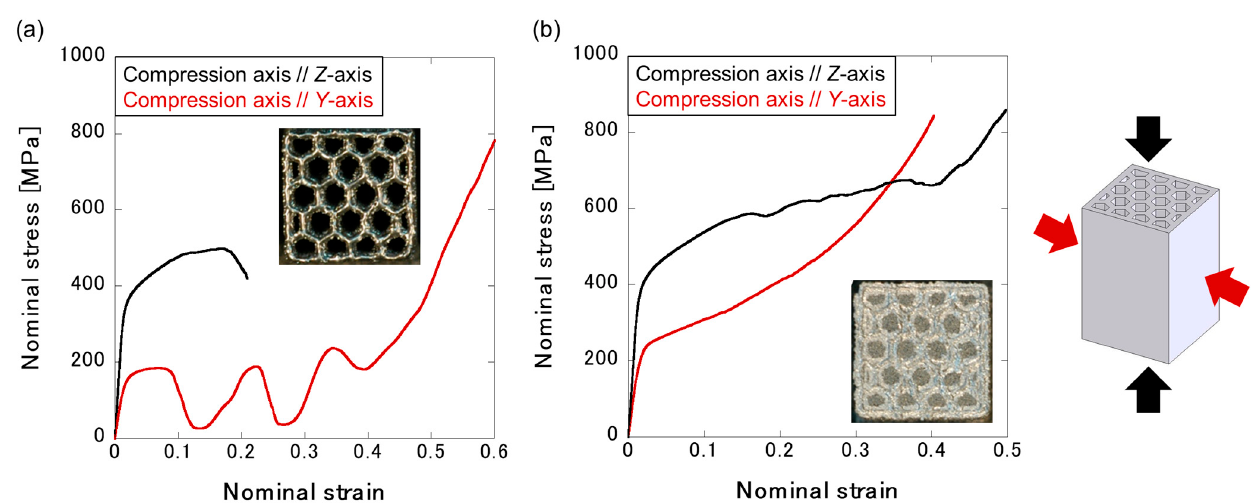
Figure 5. Orientation dependence of nominal stress–nominal strain curves in the Z - and Y -axis directions in compression at ambient temperature for ( a ) porous specimen and ( b ) composite specimen.